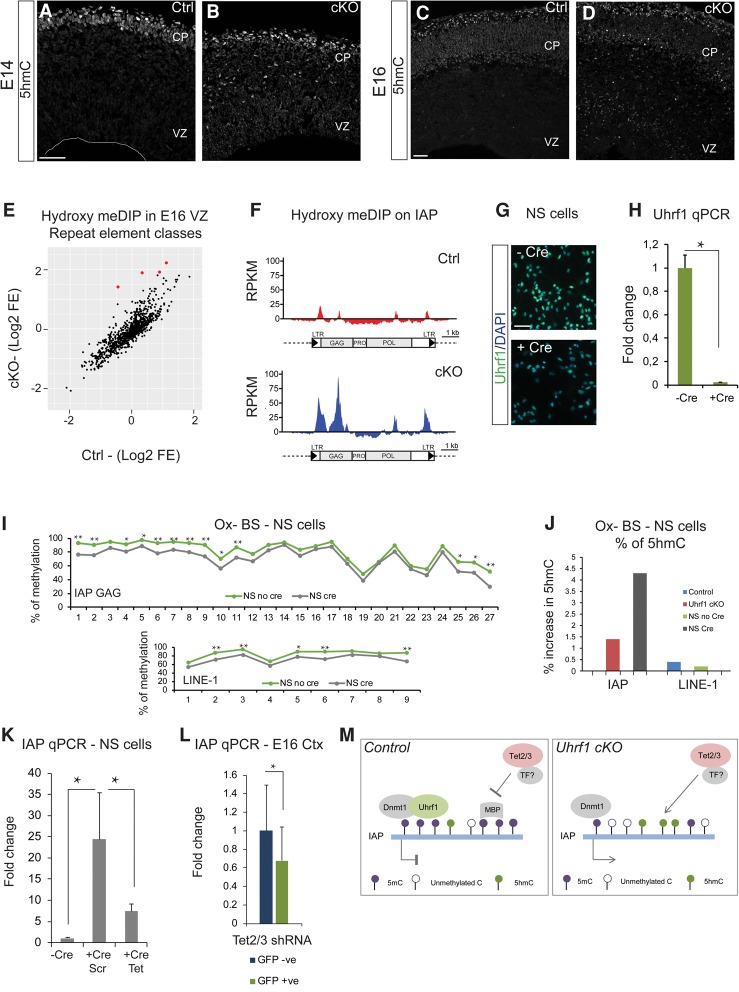
Mechanisms of IAP activation in the Uhrf1 cKO cerebral cortices. (A–D) Confocal images of coronal sections of E14 (A,B) and E16 (C,D) control and cKO cortices immunostained for 5hmC. (E) Graph depicting repeat element classes in hmeDIP of E16 VZ tissue. The X-axis and Y-axis values are log2 fold enrichment for controls and cKOs from 50-bp single-end DNA sequencing. P-value < 0.05. Red dots indicate significantly up-regulated classes in the cKO with a greater than twofold change. (F) Plot of hmeDIP peaks on IAP in E16 VZ control and cKO. The Y-axis indicates RPKM (reads per kilobase per million mapped reads) values, and the X-axis indicates the IAP sequence. (G) Epifluorescence images of NSCs immunostained for Uhrf1 and DAPI in conditions without Cre and with Cre protein added to the cultures. (H) qPCR for Uhrf1 showing strong down-regulation of Uhrf1 mRNA 4 d after Cre protein addition to the cultures. (*) P-value = 0.02. n = 4 for −Cre; n = 8 for +Cre. Error bars indicate standard error of mean. (I) Graph indicating loss of 5mC on IAP Gag and L1 loci in Uhrf1 floxed NSCs. High-throughput sequencing was performed on IAP and L1. The plot displays 27 CpGs present on IAP Gag loci, nine CpGs present on L1 loci, and their methylation status. (*) P-value ≤ 0.001; (**) P-value < 0.0001. (J) Graph indicating the percentage gain of 5hmC on IAP and L1 in Uhrf1 floxed NSCs with and without Cre protein and E16 Uhrf1 cKO cortical tissue compared with controls. The Y-axis indicates the percentage gain of 5hmC. (K) qPCR for IAP showing much reduced expression in the Tet2/3 shRNA condition compared with scrambled shRNA. Uhrf1 floxed NSCs were transfected with scrambled shRNA or Tet2/3 shRNA and simultaneously treated with Cre protein. qPCR was performed after 4 d in vitro. (*) Significance. Unpaired t-test P-value of 0.02 for no Cre versus Cre/scrambled; paired t-test P-value of 0.04 for Cre/scrambled versus Cre/Tet2,3 shRNA. n = 4 for each condition. Error bars indicate standard error of mean. (L) qPCR for IAP showing much reduced expression in the Tet2/3 shRNA GFP-positive cells compared with GFP-negative cells in vivo. Uhrf1 cKO embryos were electroporated at E13, and the GFP-positive and GFP-negative cells were isolated by FACS 3 d later. (*) P-value = 0.02, paired t-test. Error bars indicate standard error of mean. Paired statistical analysis was performed on these data, since the cells were from the same embryo either transfected or untransfected. Moreover, each pair of control and cKO showed a similar trend, with high variation between replicate pairs. (M) Model of IAP regulation in controls and Uhrf1 cKOs. In controls, IAP is highly methylated by Uhrf1, preventing access for Tet and possibly certain transcription factors to the IAP loci. In Uhrf1 cKOs, the absence of Uhrf1 leads to reduced 5mC, increased 5hmC and Tet activity, and possibly increased access for transcription factors. This allows transcription from the IAP locus. Bar, 50 µm. (TF) Transcription factor; (MBP) methylated DNA-binding protein.